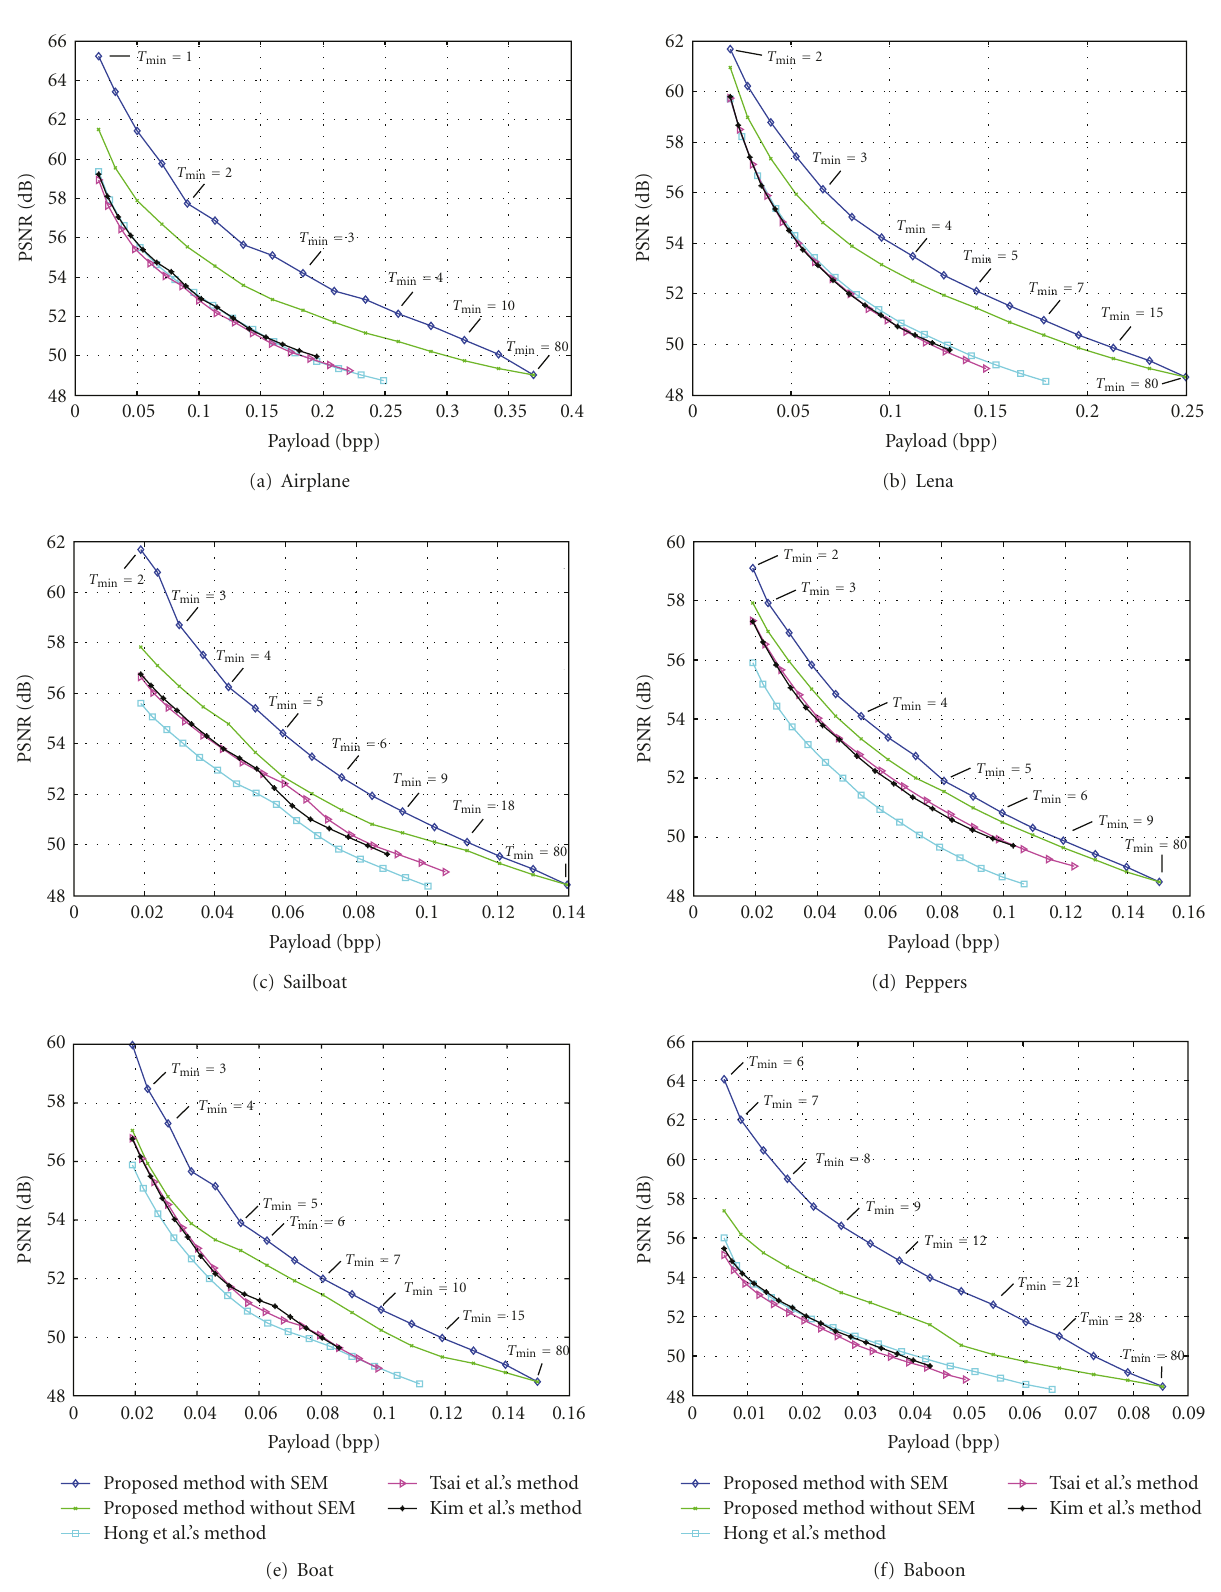
Figure 9: A comparison of various test